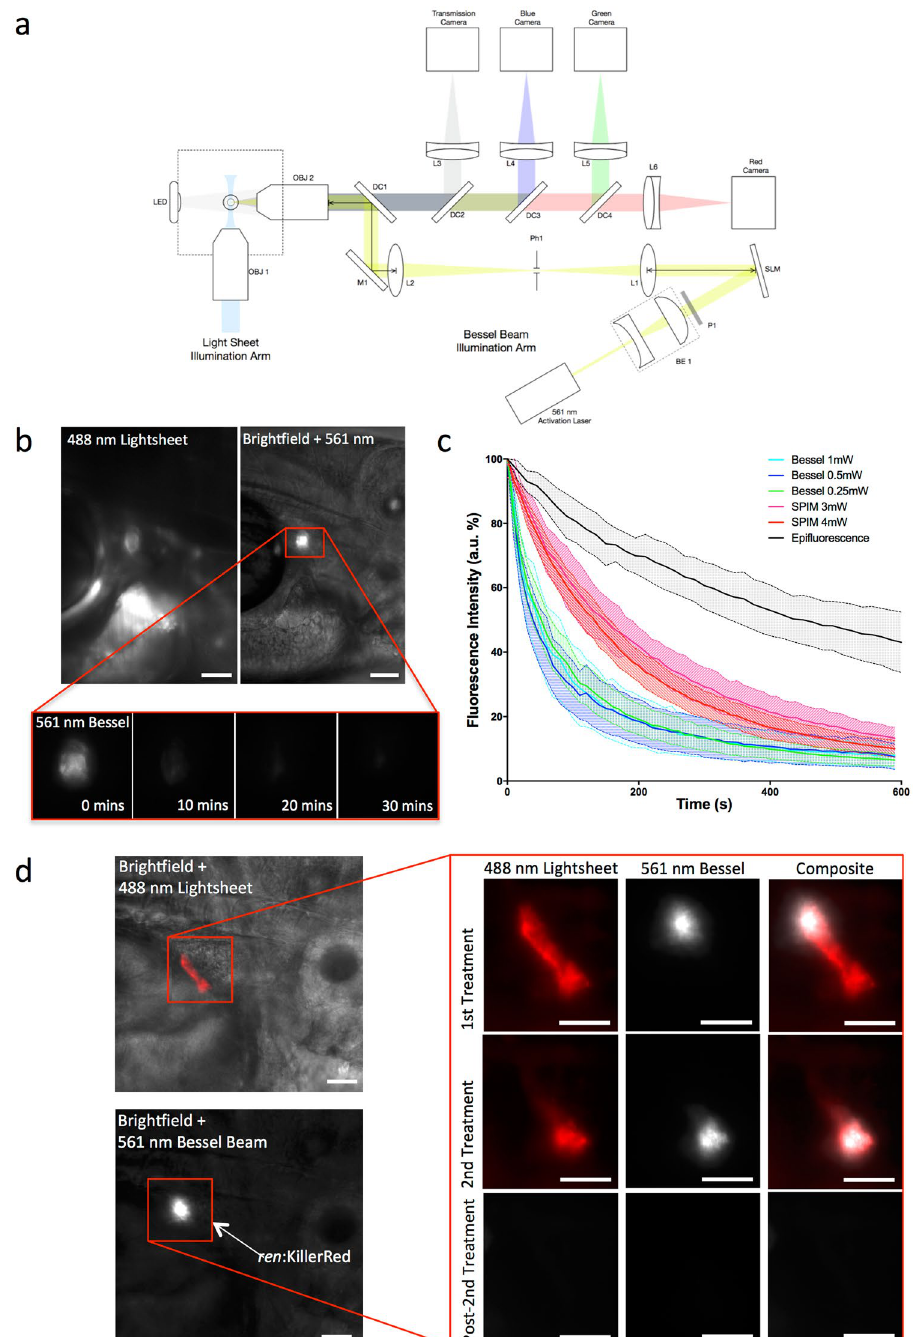
Figure 2. Introduction of a Bessel beam into the imaging path of the SPIM set up allows rapid, localised targeting of KillerRed-expressing cells in vivo . ( a ) Schematic diagram of the imaging path of the SPIM system, for fluorescence imaging, with the integrated Bessel beam for cell targeting. OBJ1, OBJ2 are objective lenses; LED, light emitting diode; DC1, DC2, DC3, DC4, dichroic mirrors; L1, L2, L3, L4, L5, L6, lenses; SLM, spatial light modulator; BE1, beam expander; P1, polarizer; Ph1, pin hole; M1, mirror. Coloured lines shown in light blue, blue, green, red, grey and yellow represent light paths for the incident SPIM light-sheet, excited blue fluorescence, excited green fluorescence, excited red fluorescence, imaged transmission light and incident Bessel beam illumination, respectively. ( b ) KillerRed cells in 3 dpf ren :mem-KillerRed larvae (indicated by the red box) were located using low power, low frame-rate 488 nm light-sheet excitation (top left panel). The 561 nm Bessel beam was translated to the correct position and superimposed with brightfield illumination for a single frame (top right panel). Brightfield illumination was then turned off and a fluorescence emission image acquired every 10 s using the Bessel illumination until the fluorescence intensity had decreased to the background level approximately 10 min later (representative images shown in bottom panel). ( c ) Graphs showing the fluorescence intensity as a percentage of the maximum intensity (arbitrary fluorescence units, a.u.), plotted against time